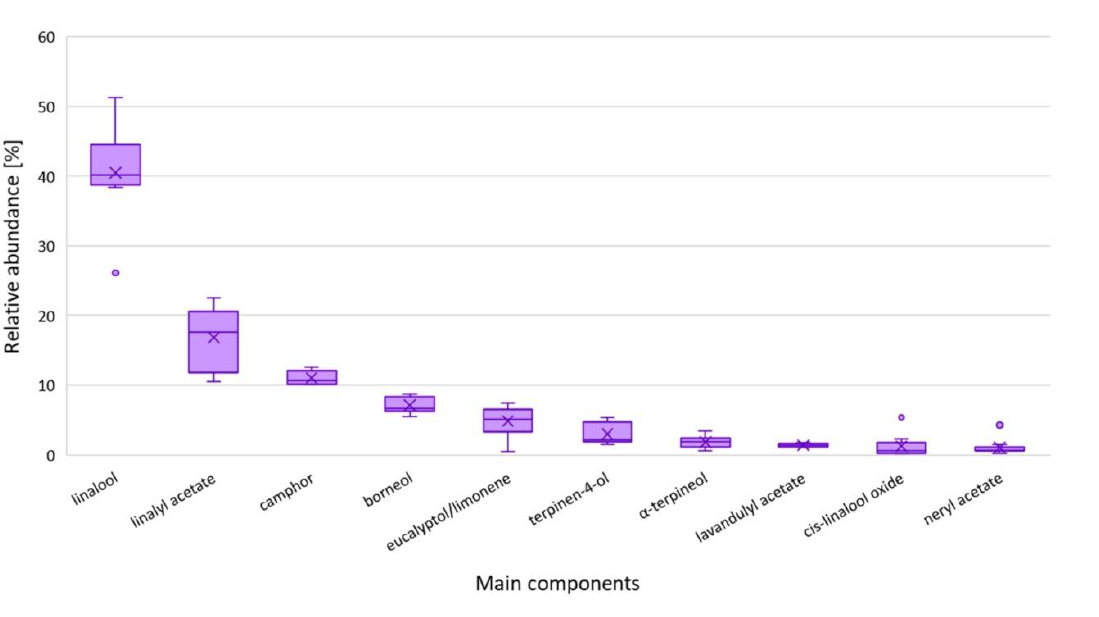
Figure 2. Box plots for relative abundancies of main components in the studied L. x intermedia essential oils. The boxes represent the Q1 – Q3 interquartile ranges. Lines intersecting the box represent the medians, and crosses represent the average value. Whiskers represent the lowest and highest results. Dots represent outlying results. Table 5. The top ten abundant components in essential oils of the studied lavandin cultivars. The compounds are ordered according to the total sum of % area for all the cultivars. Numbers are % abundances. A heatmap of all components is presented in Figure